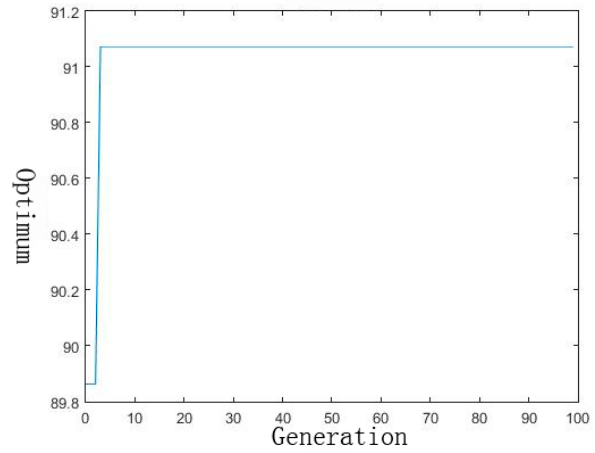
Figure 3. Evolution of fitness with 100 generations.